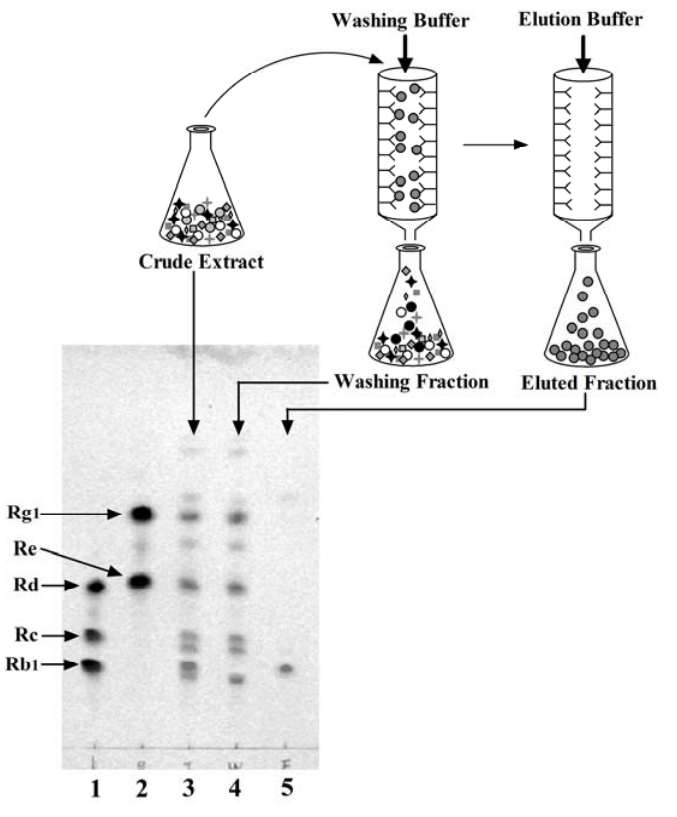
Figure 4. Preparation of the KO extract by eliminating G-Rb extract using the anti-G-Rb mAb-coupled immunoaffinity column. Lane 1: G-Rd, G-Rc, 1 , Lane 2: G-Rg and G-Re, Lane 3: crude extract, Lane 4: washing fraction, and G-Rb 1 1 Lane 5: eluted